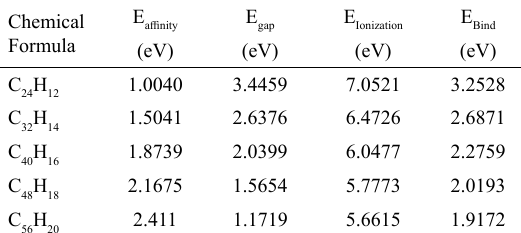
Table 3. Calculation Electron Affinity Energy, Energy Gap, Ionization Energy and Binding Energy of Circumacenes family through TIM method (1 eV = 1.6 × 10 -19 J ).